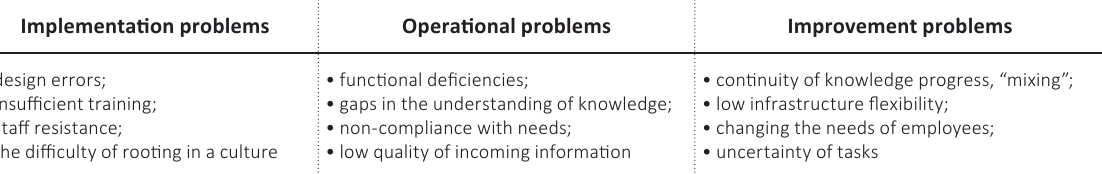
Table 2. The main problems of implementation, operation and improvement of the knowledge